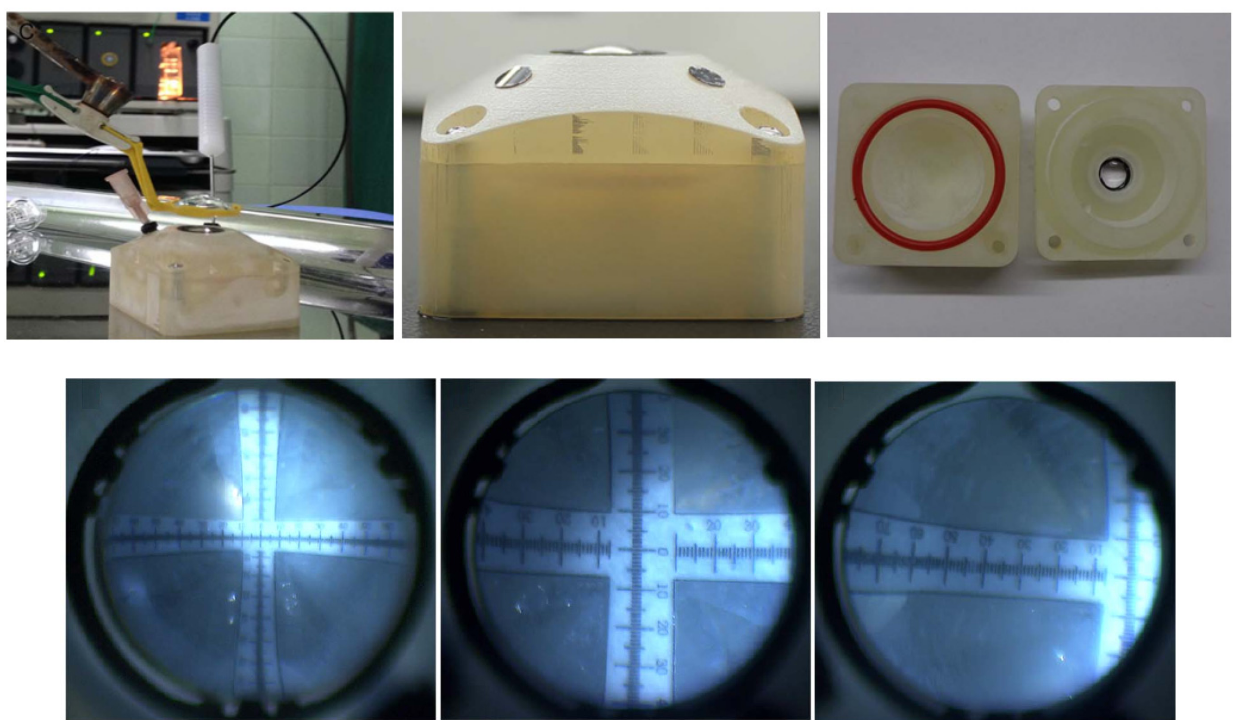
Figure 6. ( Top ) Detailed photographs of Xie et al. eye model. ( Bottom ) Photographs of fundus pictures of the angle bars photographed under 128D lens, 60D lens, and 60D lens imaged through the eye model. PLOS ONE 2014, 9, e109373 ([52]). Originally published by and reprinted with permission from PLOS ONE.